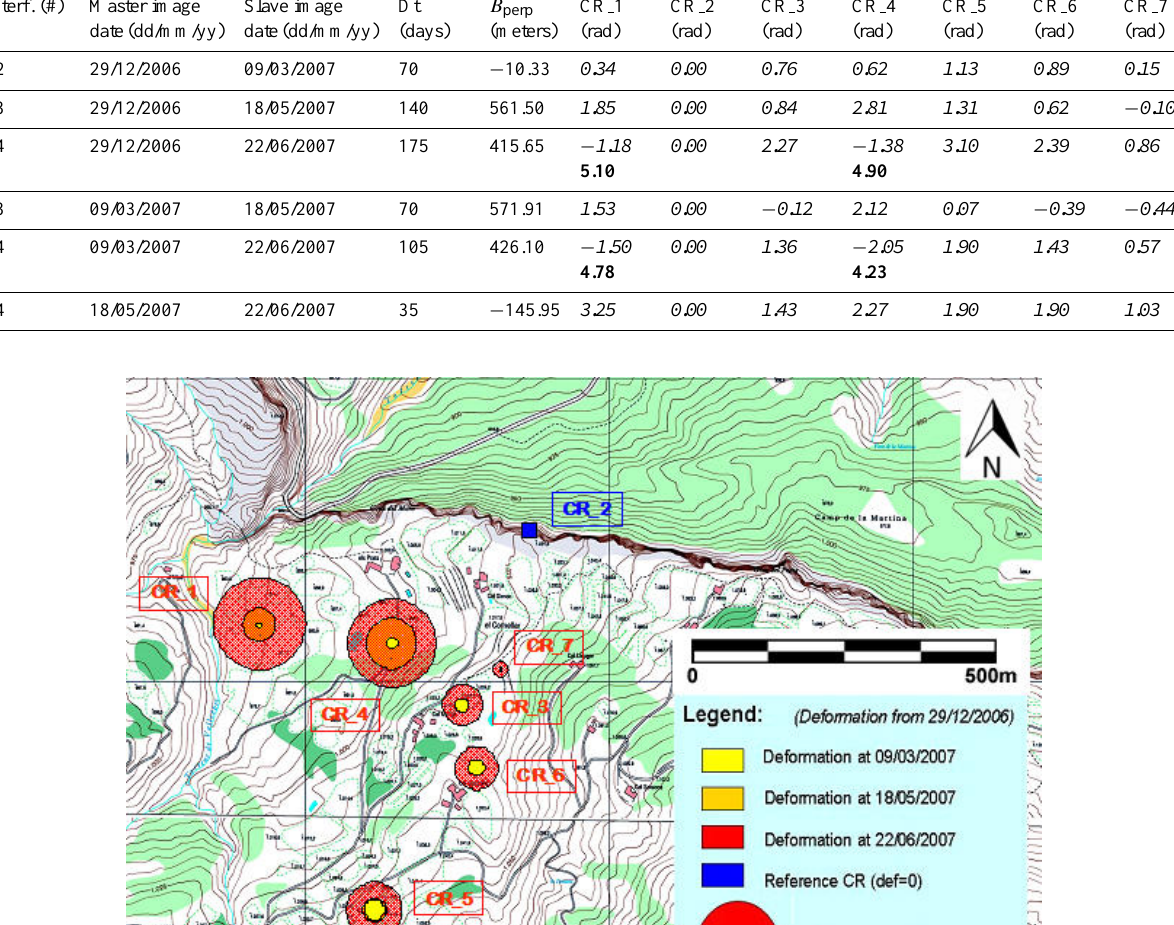
Table 1. Analysis of the six interferometric phases of seven CRs of the Vallcebre landslide. The columns contain: the interferograms number (1st); the master and slave image, with the corresponding acquisition date (2nd and 3rd); the period covered by each interferogram (4th); the perpendicular baseline (5th); and the original interferometric phases, highlighted in italic, and the unwrapped ones, in bold (6th to 12th). Interf. (#)